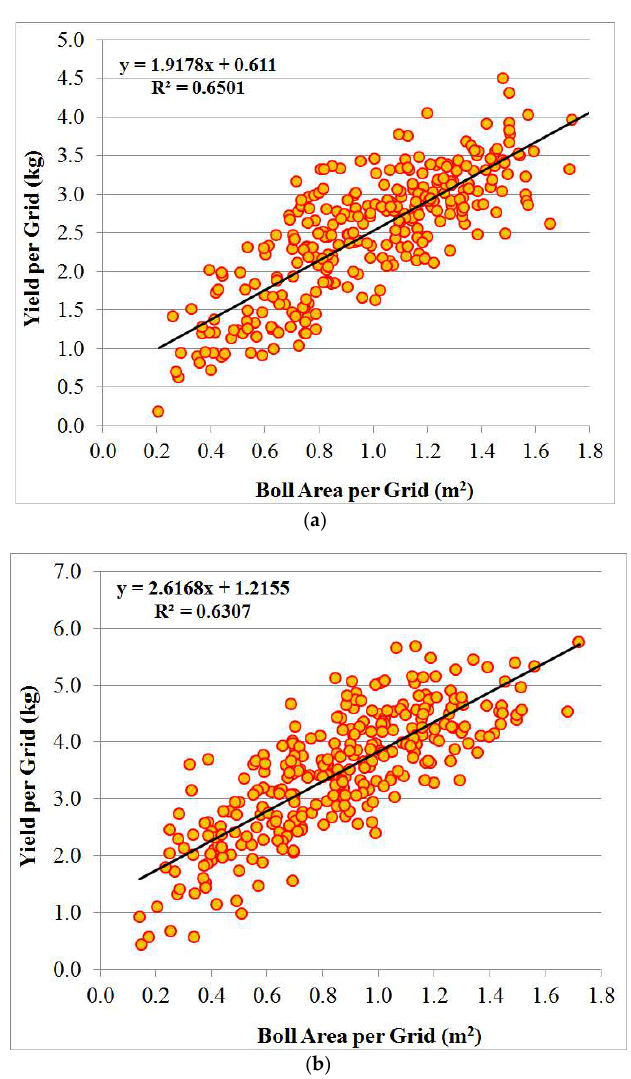
Figure 9. Linear regression analysis between boll area and harvested yield. ( a ) north and ( b ) south sites.